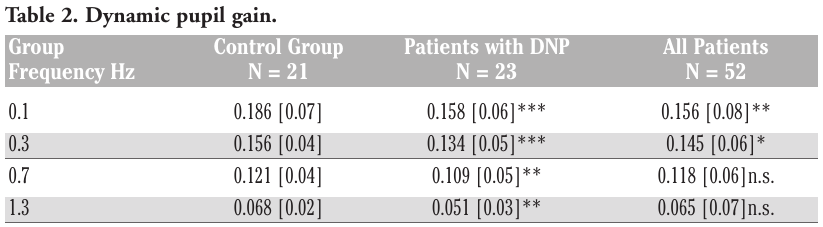
Table 2. Dynamic pupil gain.